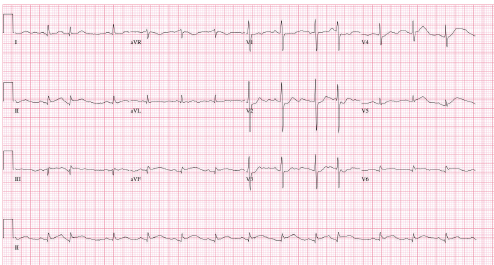
Figure 2: 12-lead EKG showing ST segment elevations in leads II, III, and aVF with reciprocal changes in anterior precordial leads, consistent with acute inferior wall ST segment elevation myocardial infarction